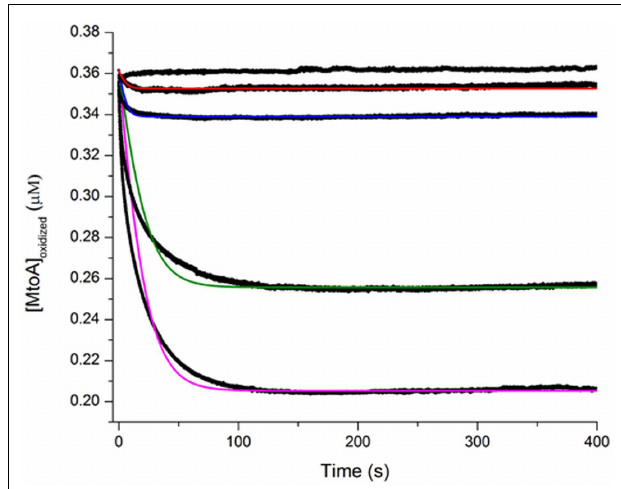
FIGURE 8 | Stopped-flow spectrophotometry results of the oxidation of 0.2mM Fe(II)-complexes by 0.4 μ M MtoA at pH 8 [black dots; from the top to the bottom is MtoA solution without Fe(II)-complexes (control), Fe(II)–EDTA, Fe(II)–NTA, Fe(II)–citrate, and Fe(II)Cl 2 ]. The fitted curves for the kinetic data of MtoA reduction with Fe(II)Cl 2 (purple), Fe(II)–citrate (green), Fe(II)–NTA (blue), and Fe(II)–EDTA (red).